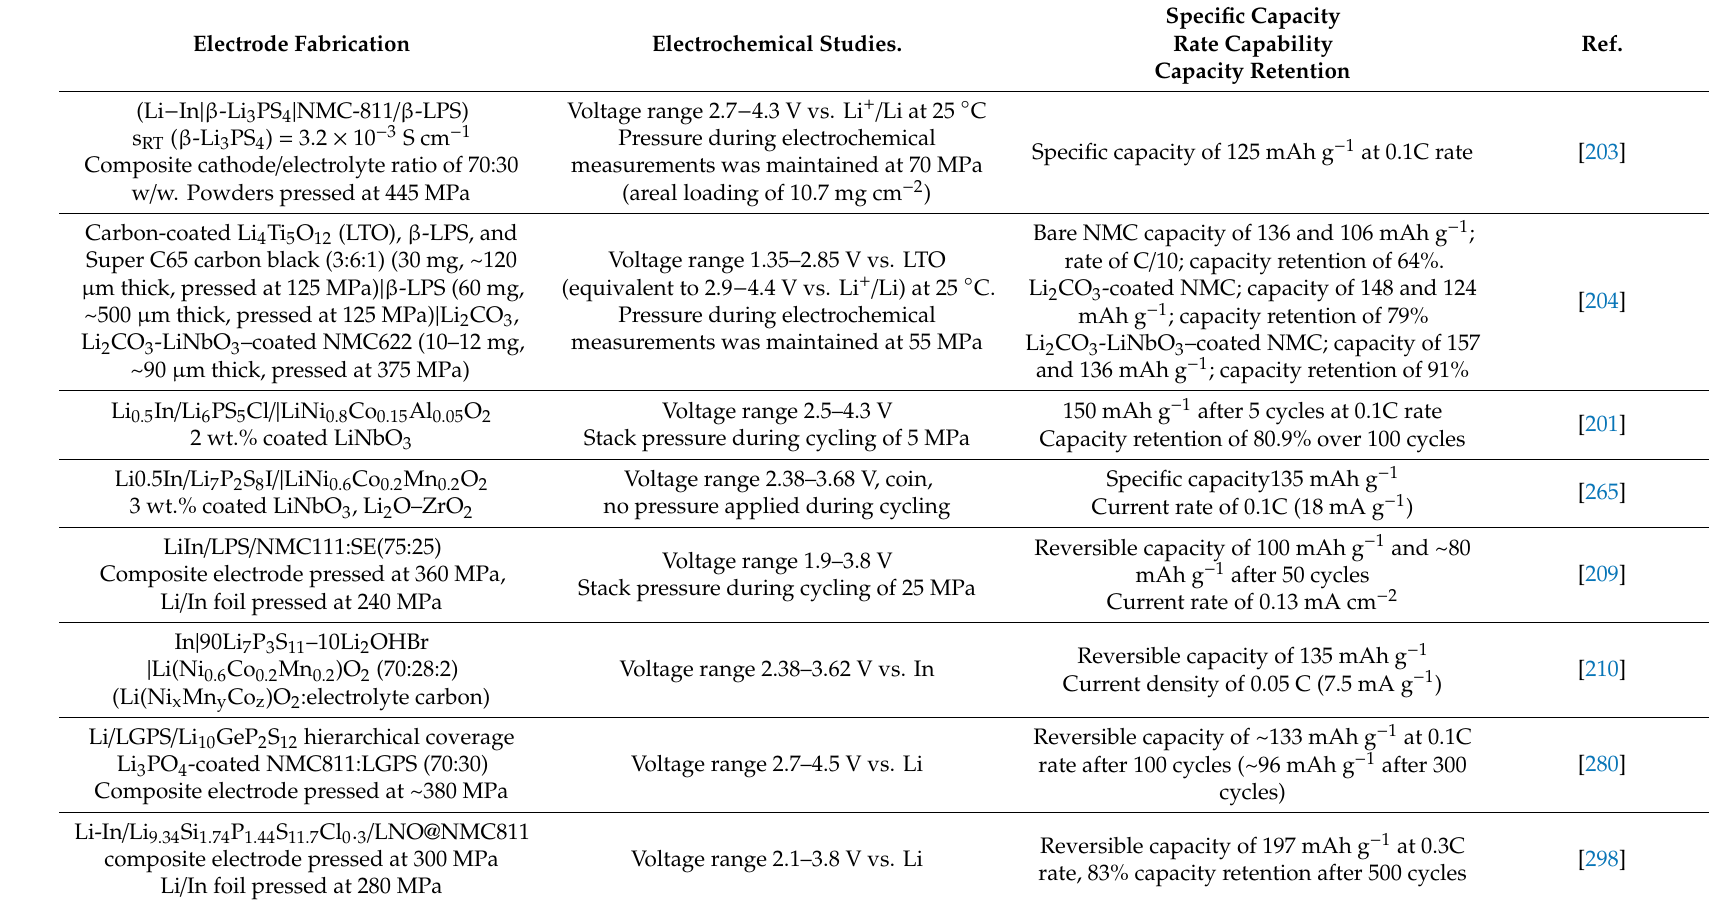
Table 2. Electrochemical performance of sulfide-based electrolytes for all-solid-state batteries.